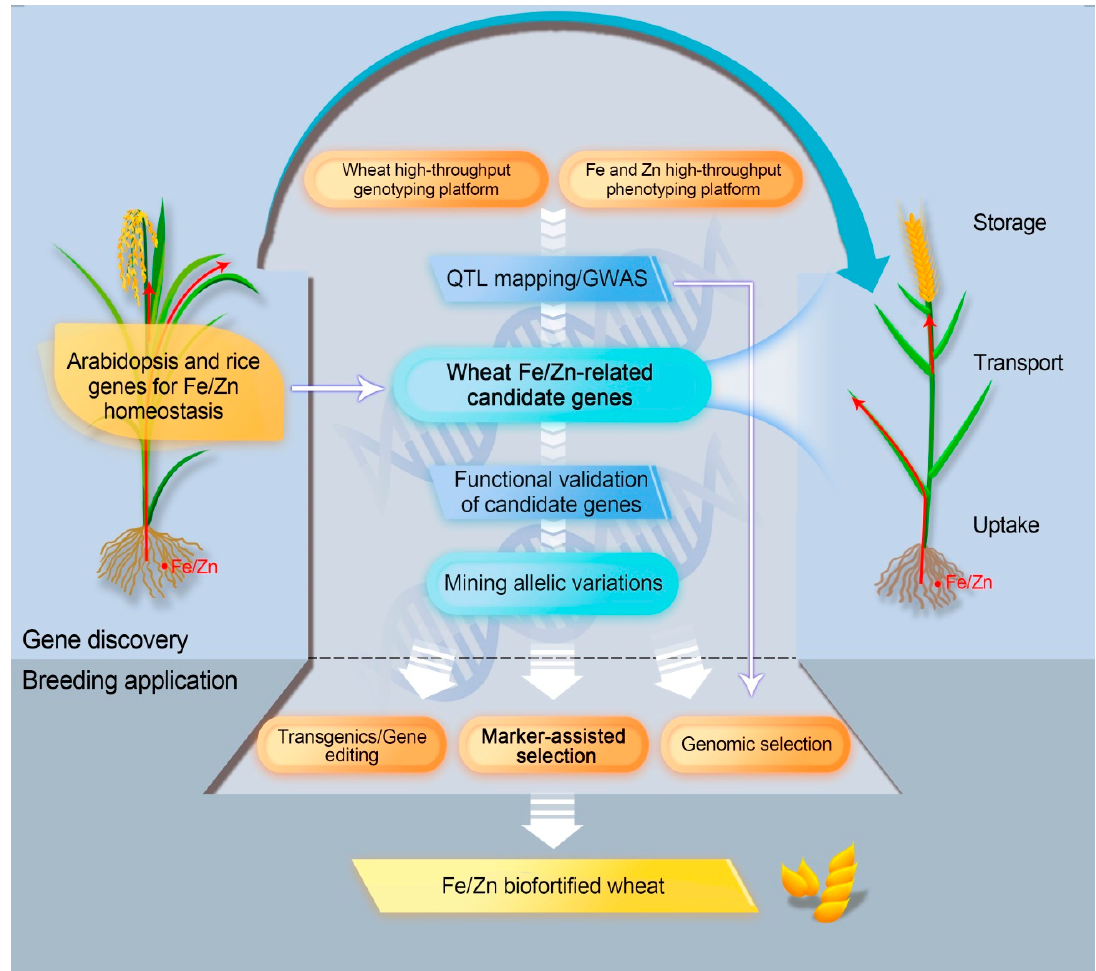
Figure 2. Schematic diagram of genetic biofortification strategies to enrich Fe and Zn in wheat grain.